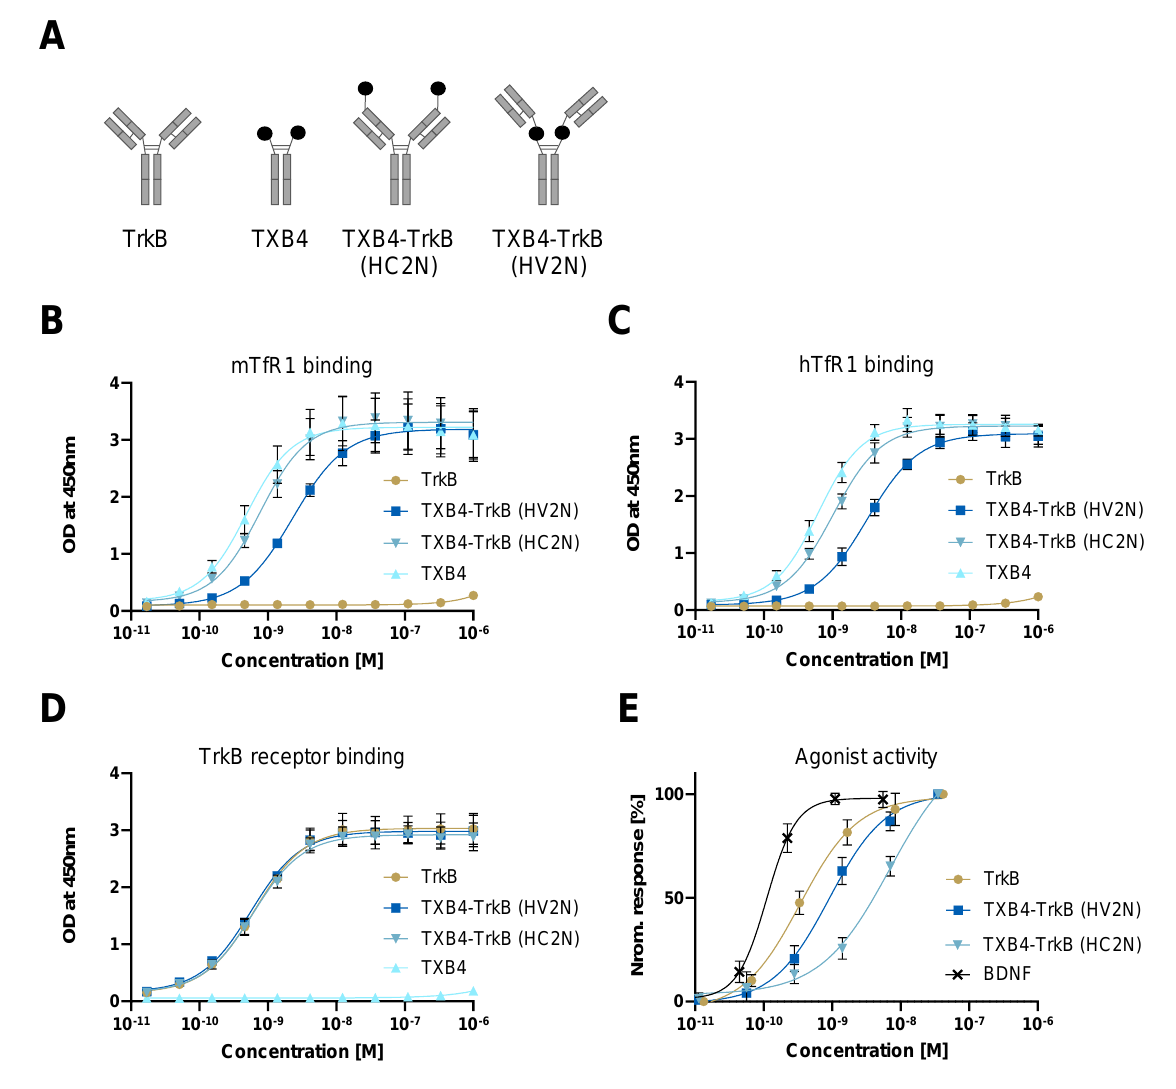
of BDNF, the dose-response curves were shifted to the right (Figure 1E). The calculated EC50 for the unmodified TrkB agonist antibody was 0.34 nM and was relatively close to 0.11 nM for the BDNF. Fusing the TXB4 module in either format reduced the potency relative to the unmodified antibody. The EC50 for the HC2N format was 6.9 nM (20-fold reduction), while that for the HV2N format was 0.9 nM (3-fold reduction) and this format over the unmodified antibody at the 18 h timepoint (Figure 2B). The plasma concentration was selected for further animal studies (Table 2). The control TXB4-TrkC antibody fusion between the TrkB antibody (218 nM) and the TXB4 fusion (187 nM) were not significantly in the HC2N format retained was a full agonist in the TrkC-NFAT-bla CHO-K1 assay and different (Figure 2C). For the control TXB4-TrkC antibody, the brain concertation averaged had an EC50 of 3.1 nM (data not shown). 6.5 nM at 18 h after IV in injection with 25 nmol/kg compared to 0.3 nM for the unmodified TrkC agonist antibody.